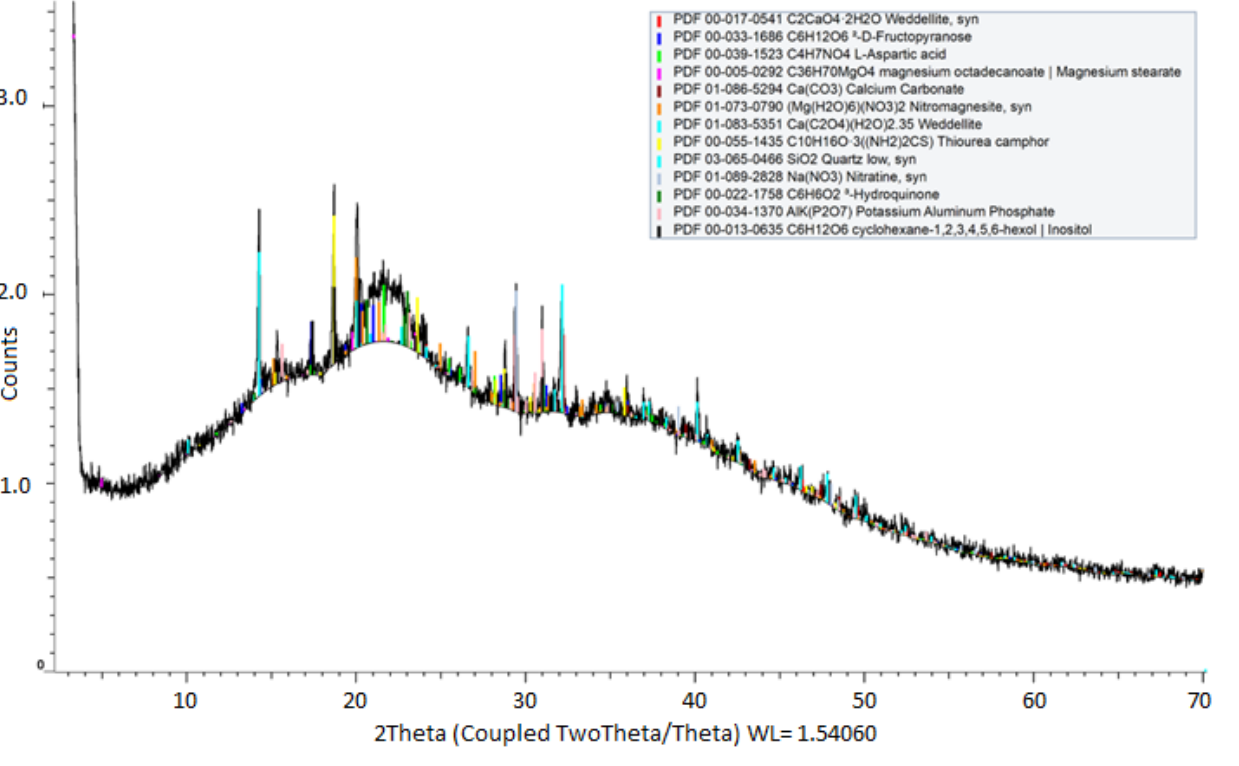
Figure 2. Powder diffraction pattern of a solid sample of mucilage extracted from pitaya fruit peel (black line). In color, the different crystallographic phases are identified. (black line). In color, the different crystallographic phases are